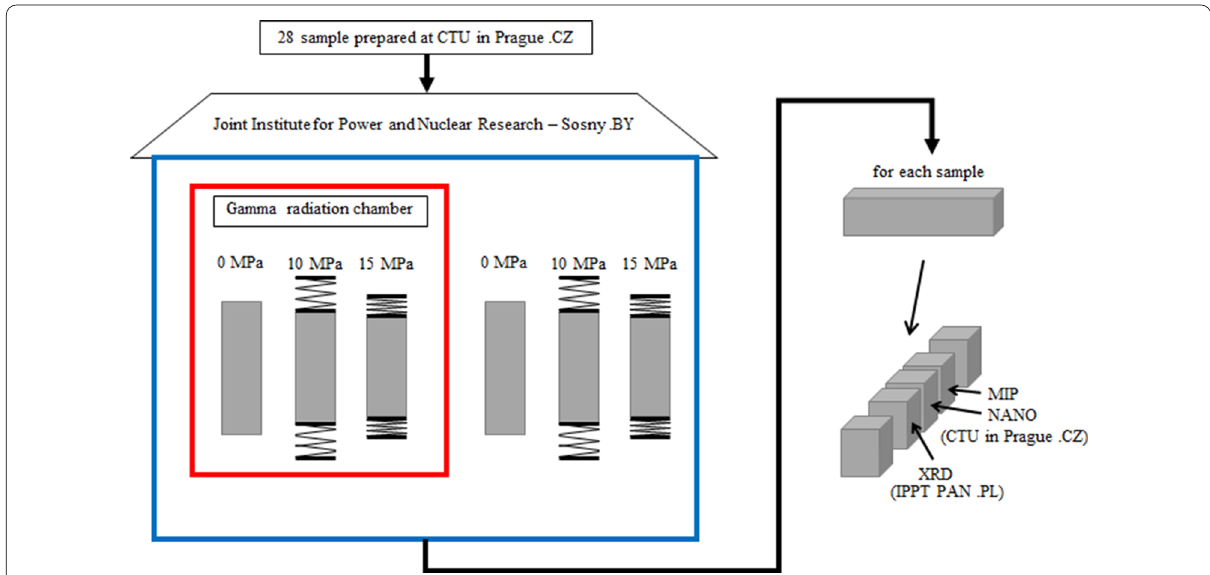
Fig. 2 Schematic description of experiment, where “Nano” stands for nanoindentation.